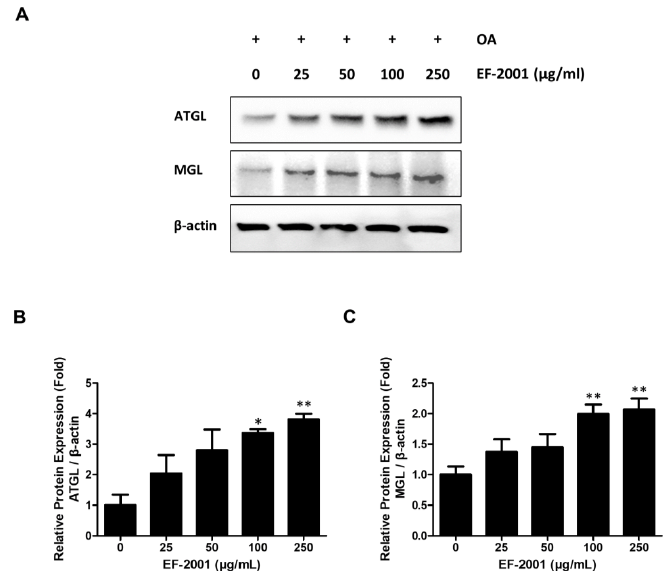
Figure 4. Effects of EF-2001 on lipase in FL83B hepatocytes. FL83B hepatocytes were treated with 0.5 mM oleic acid (OA) for 48 h to induce lipid accumulation. Media was changed in the absence or presence of various doses of EF-2001. Cells were harvested at the time at which the expression of each lipase protein was induced, and Western blotting was performed to determine the expression levels of ( A ). ( B ) Cells were sampled by lysis buffer after EF-2001 treatment for adipose triglyceride lipase (ATGL) (6 h). ( C ) Cells were sampled after EF-2001 treatment for monoacylglycerol (MGL) (12 h). Data are represented as mean ± SEM. ( n = 3); * p < 0.05 and ** p < 0.01 vs. control.